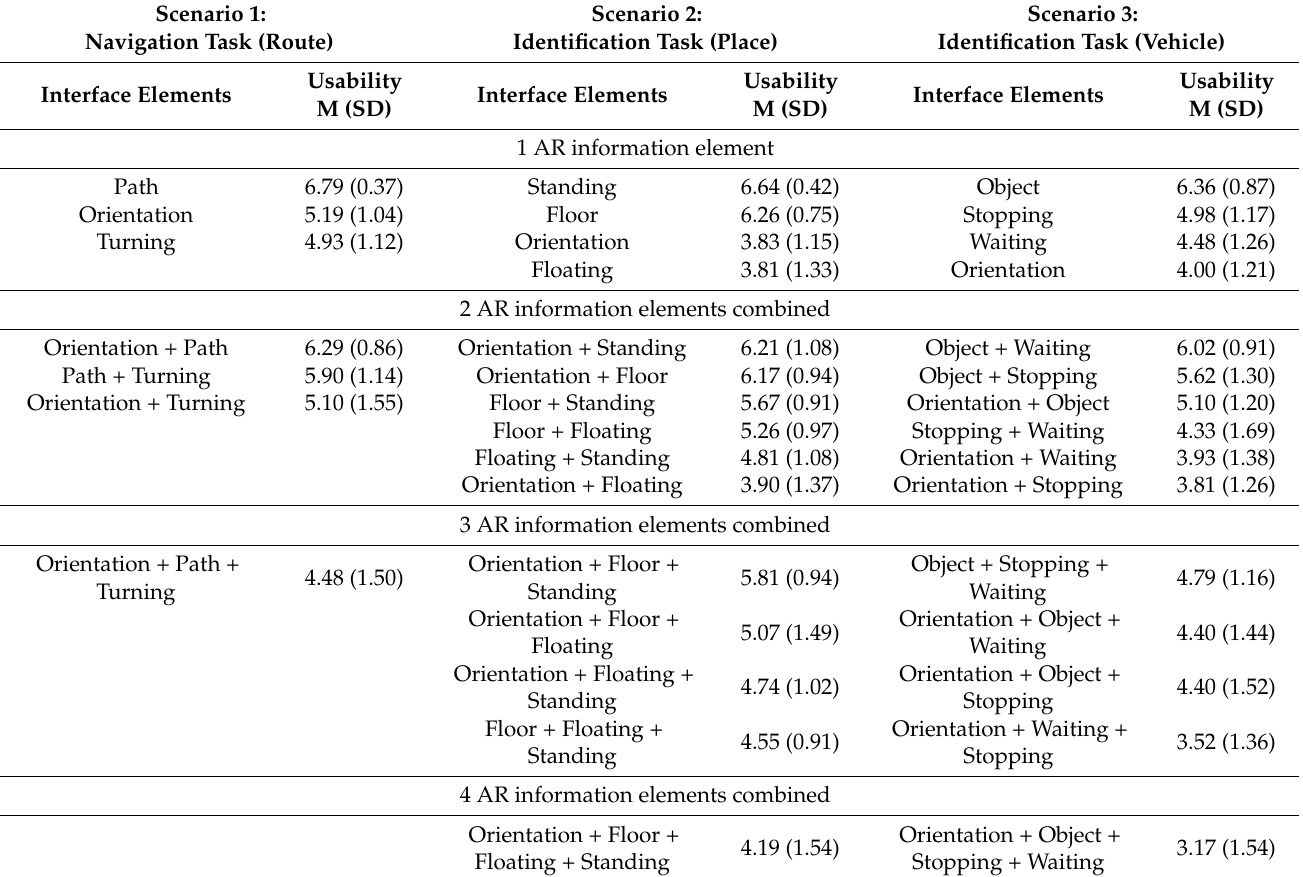
Table 2. Usability rating of arranged AR interfaces by participants of the first user study (N =